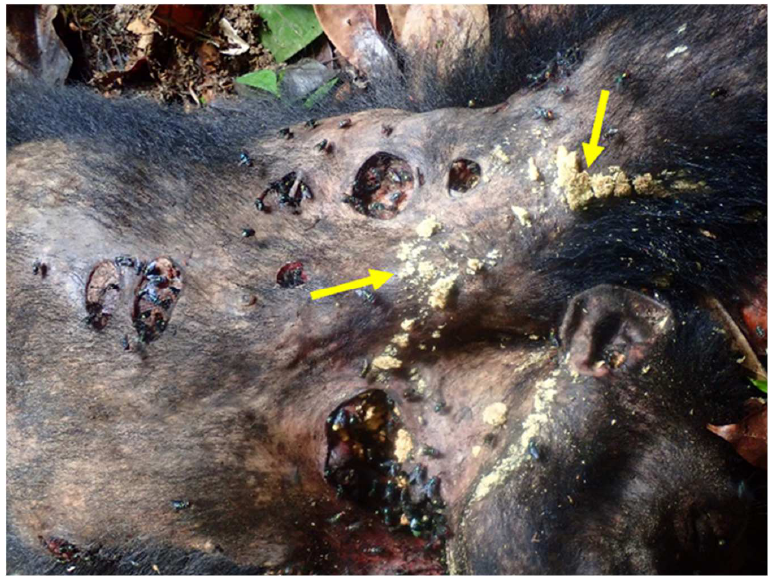
Figure 3. Flies feeding and laying eggs (arrows) on a dead chimpanzee. Photo courtesy of Jennifer Jaffee and the Tai Chimpanzee Project.